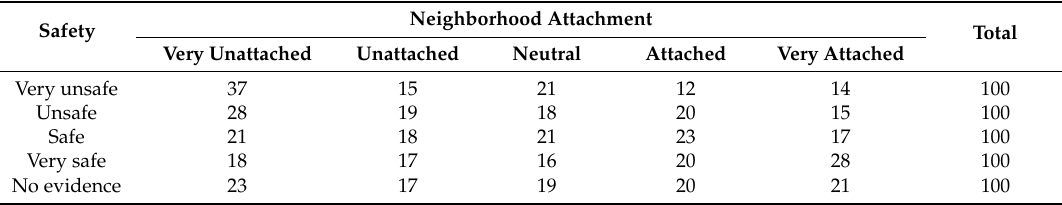
Table 11. Updated probabilities (in %) for neighborhood attachment based on neighborhood safety.